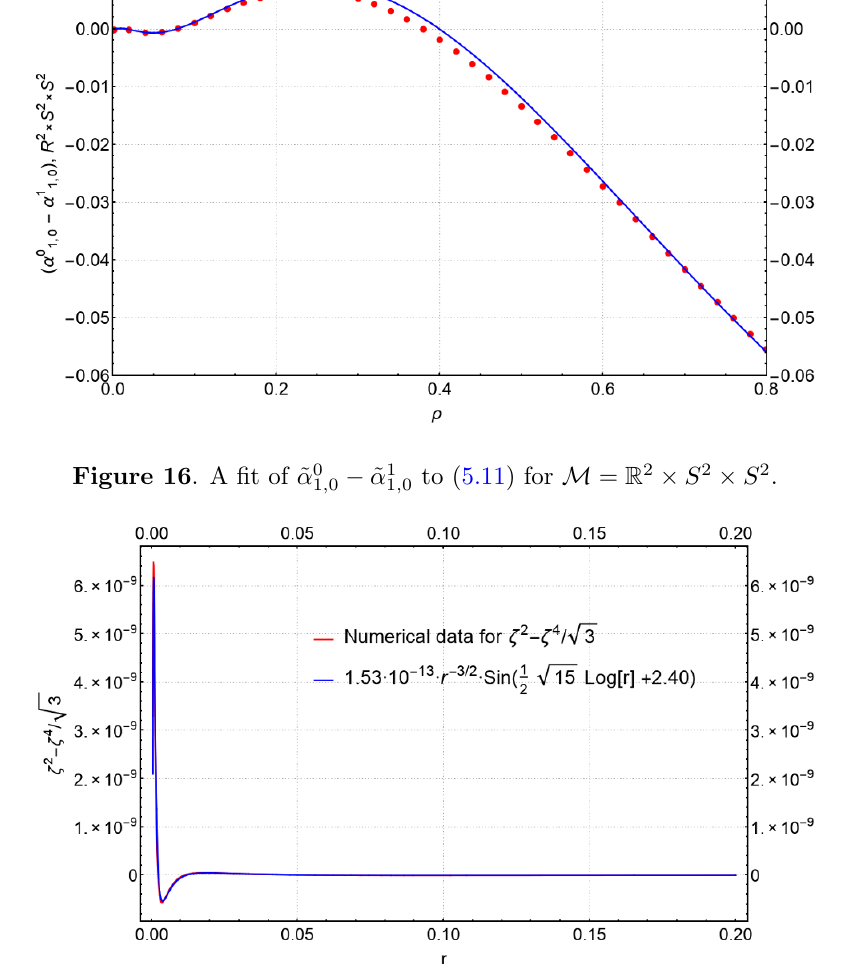
p 3 for M = S 2 (cid:2) S 4 , (cid:12)t to the behavior (5.14).